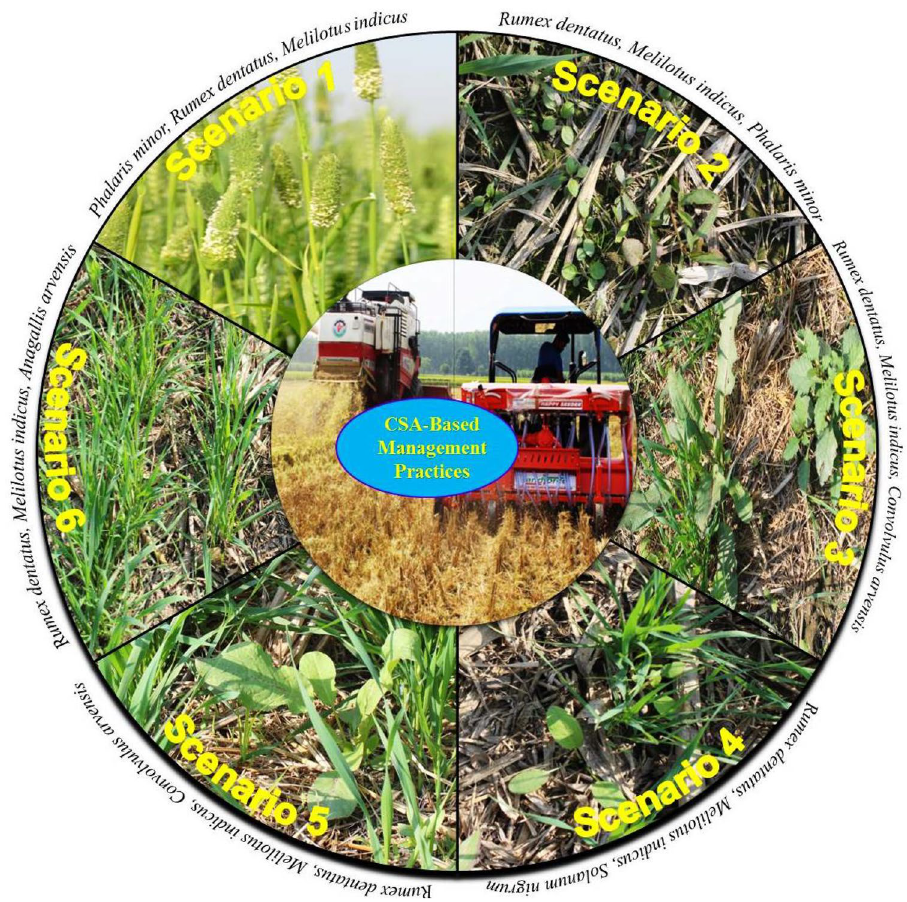
Figure 1. Schematic diagram of dominant weed species under climate-smart agriculture (CSA)-based management scenarios. Sc1 conventional rice–wheat system with flood irrigation (FI), Sc2 conservation agriculture (CA)-based rice–wheat–mungbean system with FI, Sc3 partial CSA-based rice–wheat–mungbean system with FI, Sc4 partial CSA-based maize–wheat–mungbean system with FI. Sc5 full CSA-based rice–wheat– mungbean system with subsurface drip irrigation (SDI), Sc6 full CSA-based maize–wheat–mungbean system with SDI. The figure has been generate using Microsoft PowerPoint office professional Plus (2010), version